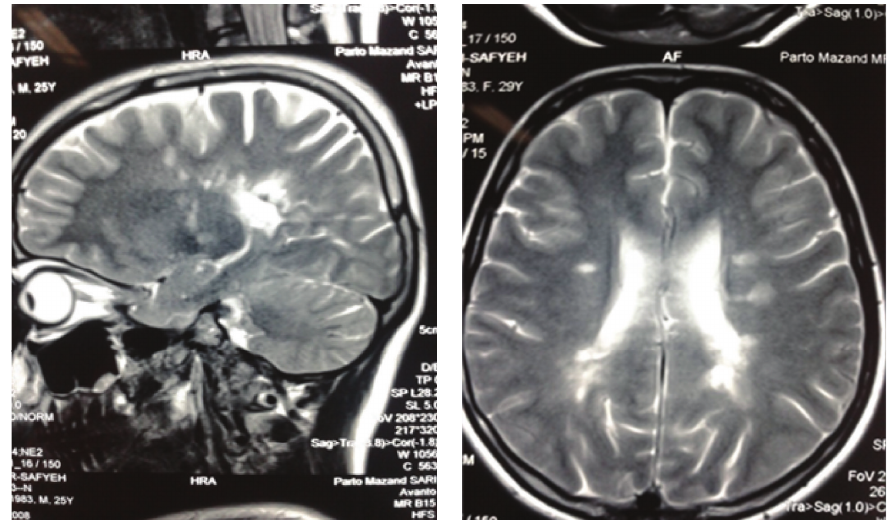
Figure 1: T2 MRI: periventricular plaques.